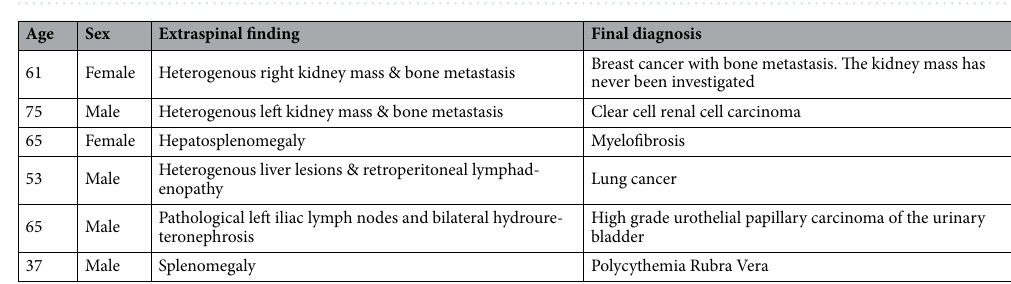
Figure 5. A 49-year-old female with appendiceal mucocele. ( a ) Axial T2 weighted image showing a cystic lesion in relation to the cecum (white arrow). ( b ) Axial T2 weighted image at a lower level showing the tubular shape of the cystic lesion (white arrow). (c) Coronal CT scan reconstruction with oral and IV contrast performed 2 years later demonstrated the same cystic lesion in relation to the cecum with faint wall calcifications (white arrow).